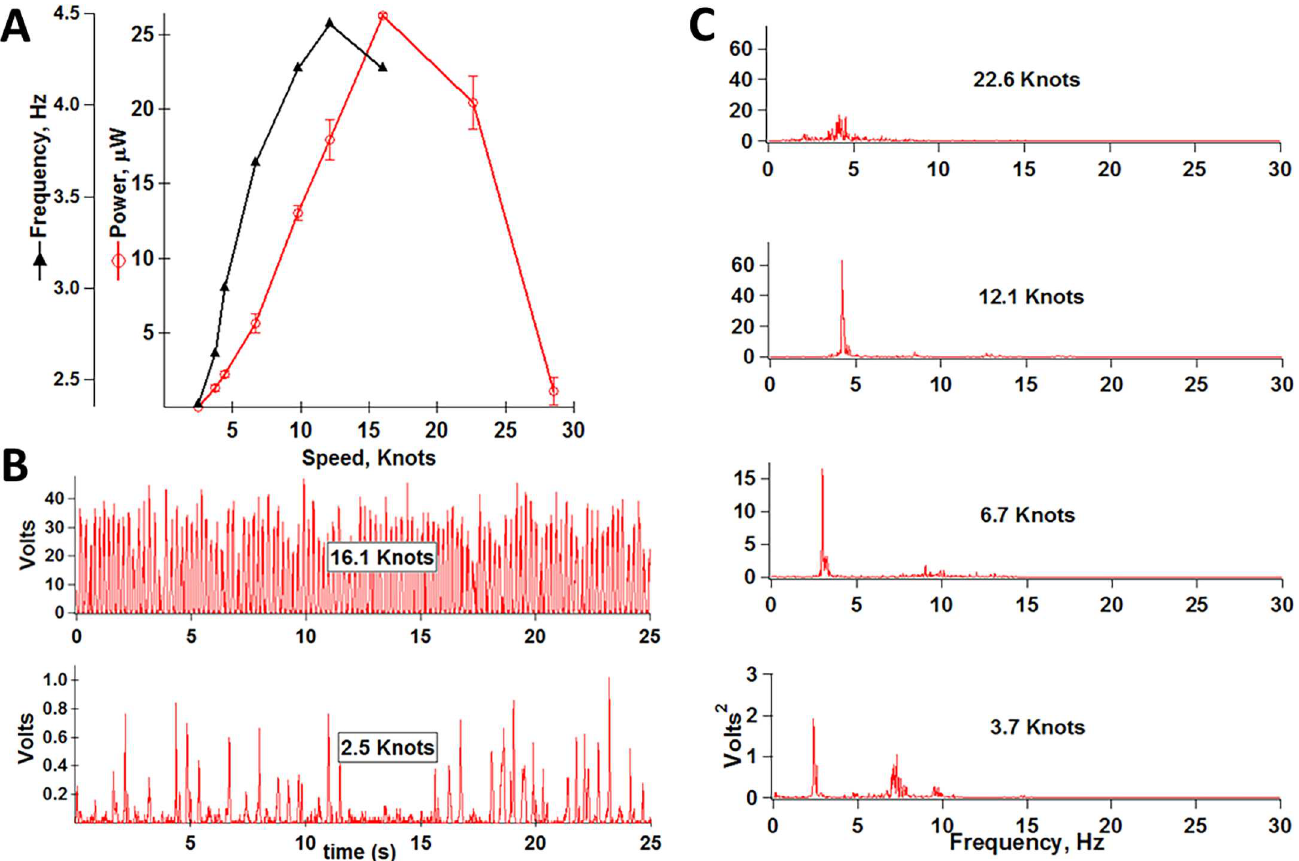
Fig 1. Propertiesof model cottonwood leaf in fan-generated wind: (A) Power dissipatedacross 10 M Ω load (circles), and frequency of major band (triangles) as function of wind speed; (B) Raw voltage data at two wind speeds; (C) Power spectra at four wind speeds, showingshift of major band to higher frequencies with increasein wind speed. Leaf was angled60 degreesdownwardfrom horizontal.